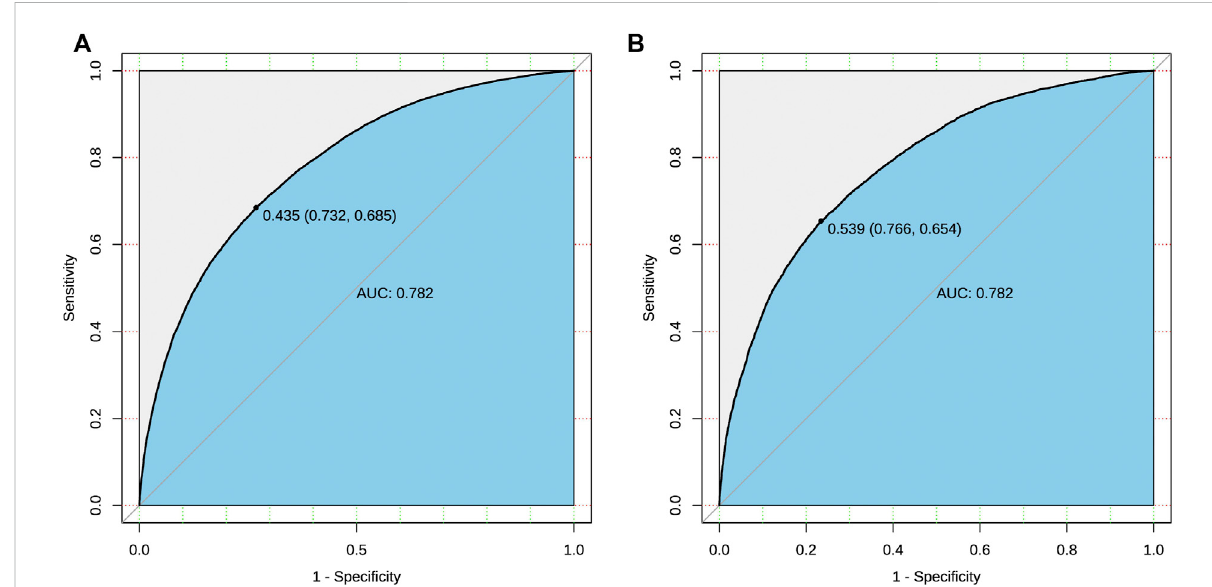
FIGURE 3 ROC curve of the risk prediction model for polypharmacy in the elderly. The black bold line represents the performance of the nomogram in both sets respectively [ (A) : training set; (B) validation set]. The y -axis represents the true positive rate of risk prediction, and the x -axis represents the false positive rate of risk prediction.